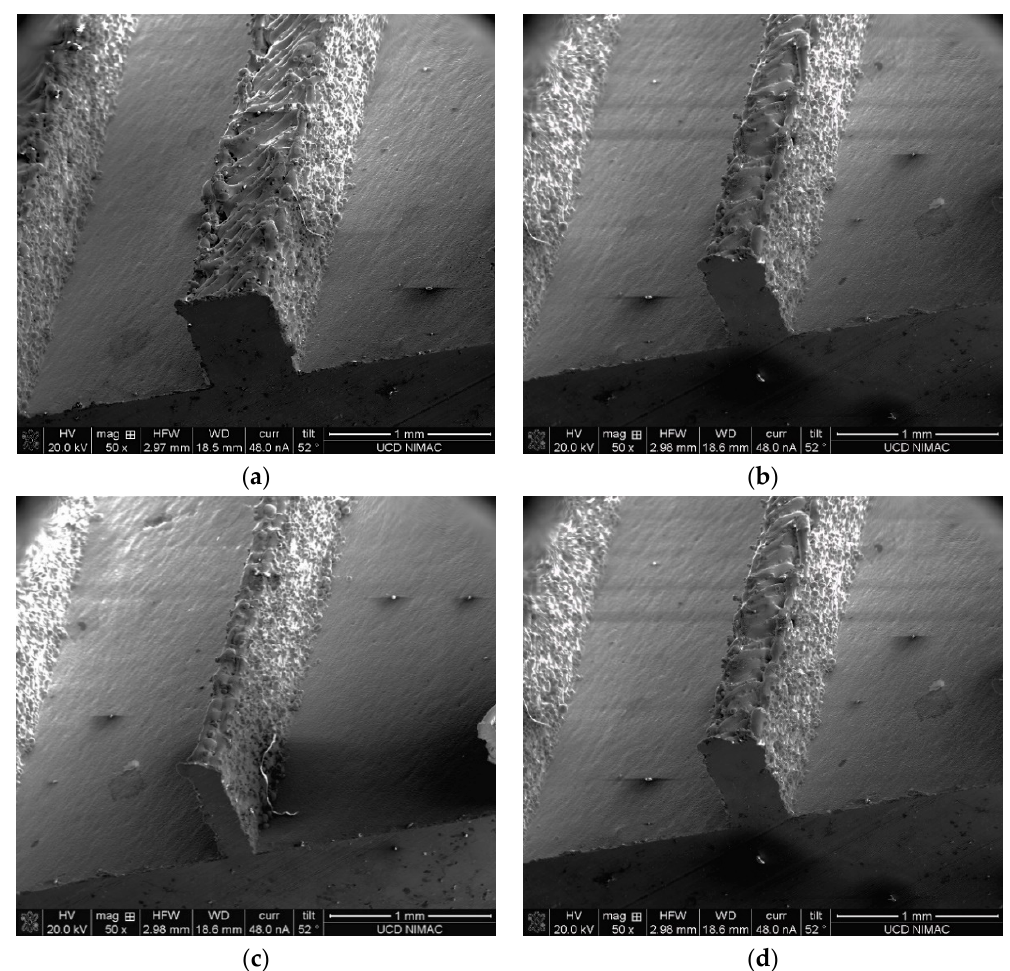
Figure 5. Cross-section of printed features of testing pattern of ( a ) 0.6 mm, ( b ) 0.4 mm, ( c ) 0.2 mm and ( d ) 0.1 mm. Scale bar = 1.0 mm in all cases.